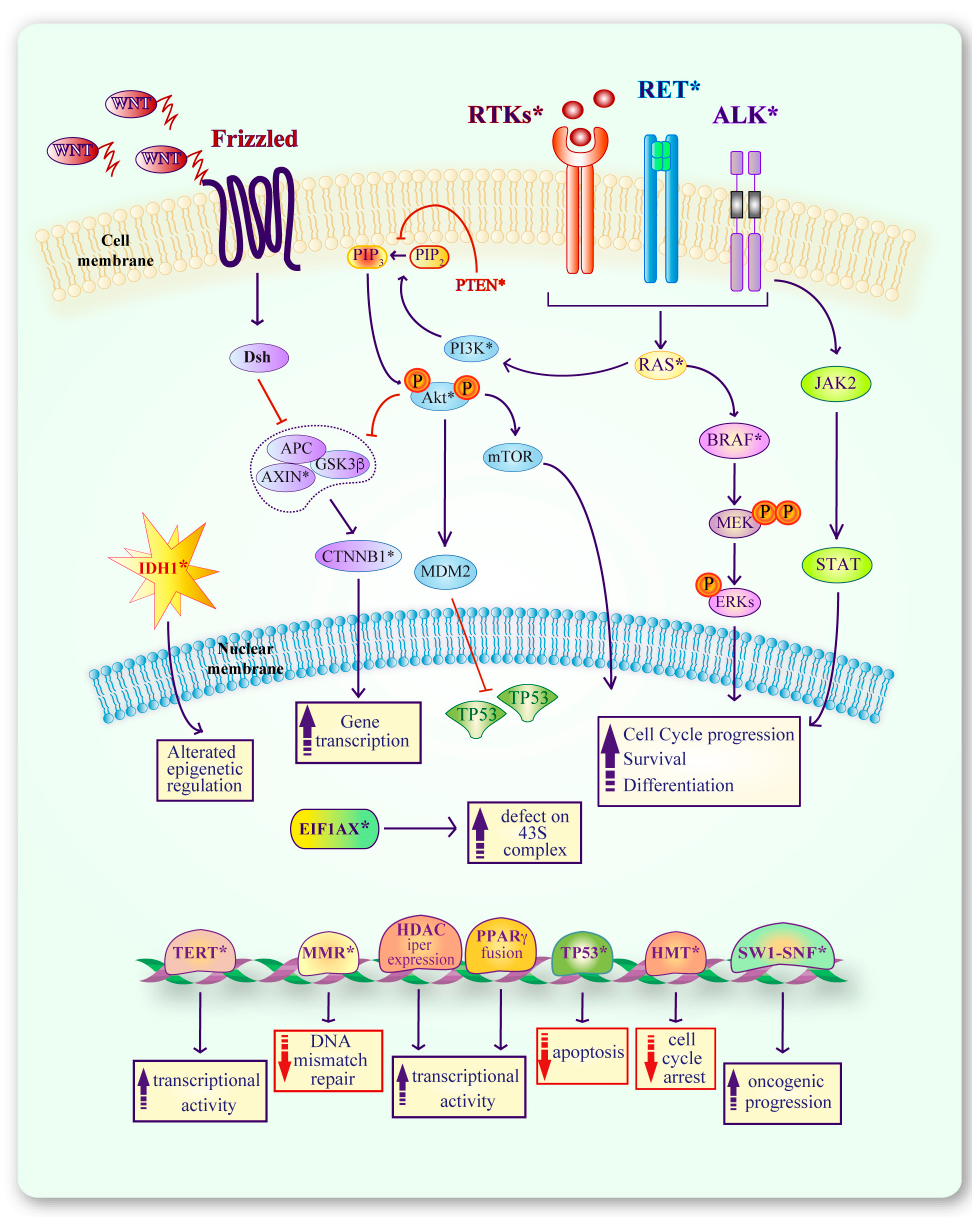
Figure 3. Molecules and cellular pathways that contribute to thyroid cancer development. Alterations in ALK, RET or other RTKs up-regulate RAS thereby pathologically modulating the MAPK and PI3K pathways that favor thyroid cell survival, de-differentiation and improper gene transcription. Mutations in the WNT pathway (CTNNB1, AXIN) and in other molecules (TERT, PPAR γ , HMT, SW1-SNF, TP53) promote oncogenic activity, reduce apoptosis and compromise DNA repair (MMR). IDH1 or EIF1AX mutations alter epigenetic mechanisms or cause a defective assembly of the 43S-complex, respectively. Additional mutations in specific genes (BRAF, PTEN) promote the transition from differentiated to undifferentiated thyroid cancer. * indicates genes directly involved in thyroid carcinogenesis